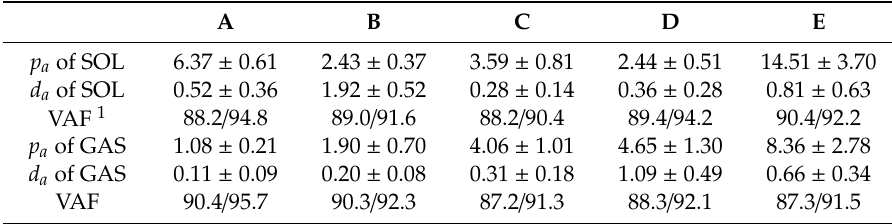
Table 2. The forepart mean reflex gains for all five subjects.